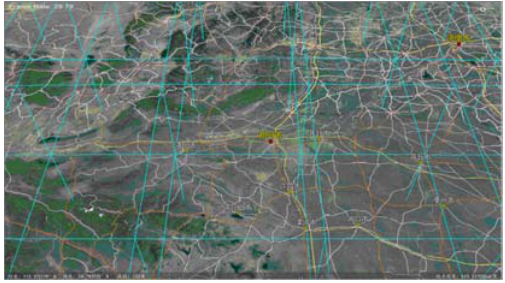
Figure 20. SSSG (blue wire frame) over local region. (2) Space orbit objects representation In this example, the satellite position is described in SSSG grid code form dynamicly (Figure 21).